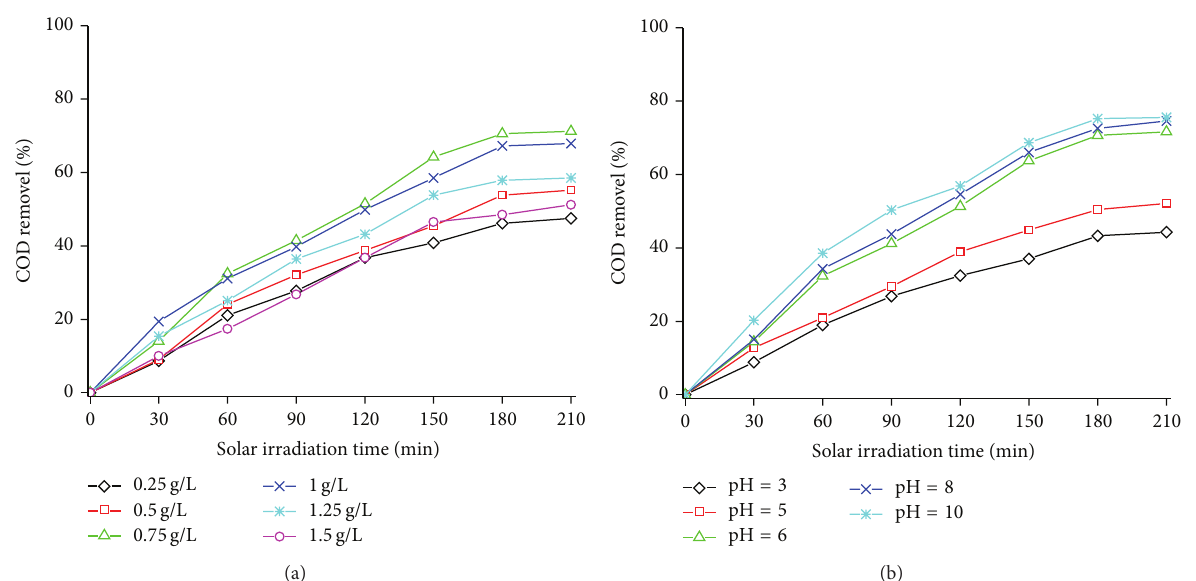
Figure 4: (a) %COD removal during the treatment of the wastewater by solar photocatalytic oxidation against solar irradiation time at different loading of TiO 2 [pH = 6.5], (b) %COD removal during the treatment of the wastewater by solar photocatalytic oxidation against solar irradiation time at different pH values [TiO 2 = 0.75 g/L]. (Figure 4 is reproduced from reference [24]. Copyright 2011, with permission from Elsevier).